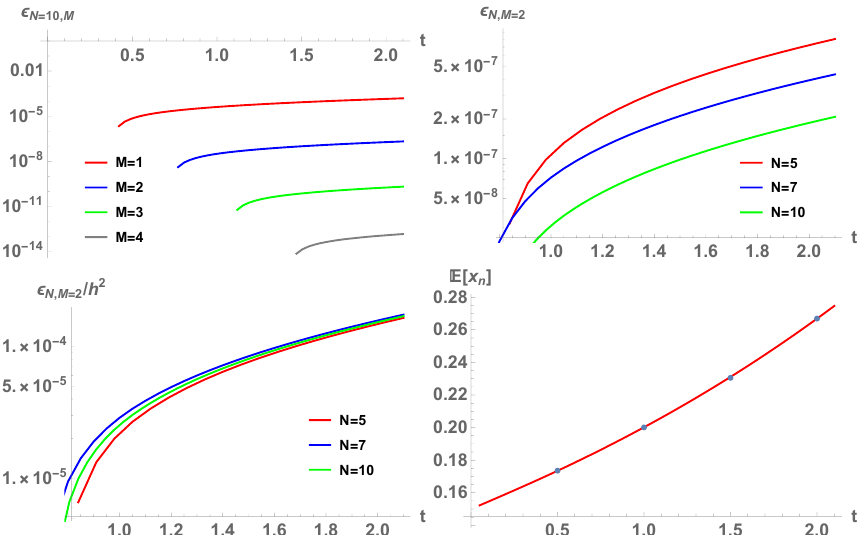
Figure 5. Upper left panel: Absolute errors (log-scale) in the approximation of the mean value with the NSFD scheme, with M = 1,2,3,4 and N = 10 ( h = τ / N ). Upper right: Absolute errors (log-scale) in the approximation of the mean value with the NSFD scheme, with N = 5,7, 10 ( h = τ / N ) and M = 2. Lower left panel: Errors from the upper right panel divided by h 2 . Lower right panel: Approximation of the expectation with the NSFD scheme, with M = 2 and N = 7, and comparison with Monte Carlo simulation (circles) using 10,000 realizations. This figure corresponds to Example 3.